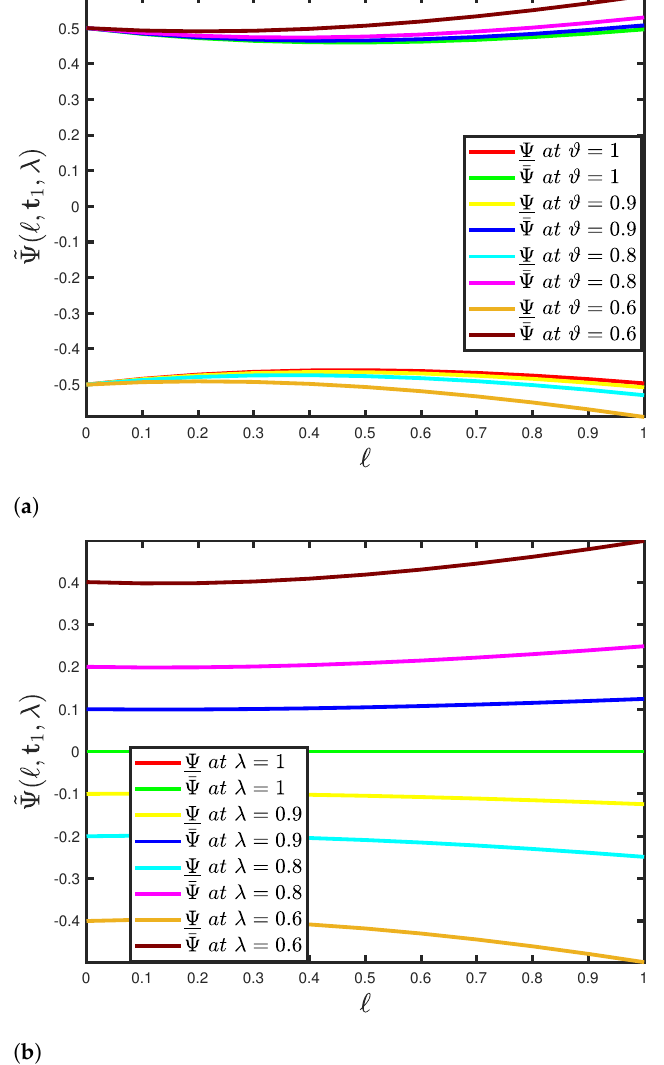
Figure 3. Two-dimensional simulation of ˜ Ψ ( (cid:96) , t 1 ; λ ) of Problem (1): ( a ) Ψ ( (cid:96) , t 1 ; λ ) and ¯ Ψ ( (cid:96) , t 1 ; λ ) when fuzzy ABC is considered to have an uncertainty parameter λ ∈ [ 0,1 ] and t 1 = 0.7; and ( b ) Ψ ( (cid:96) , t ) and ¯ Ψ ( (cid:96) , t ) when fuzzy ABC is considered to have a fractional order ϑ = 0.7 and 1 ; λ 1 ; λ t 1 =